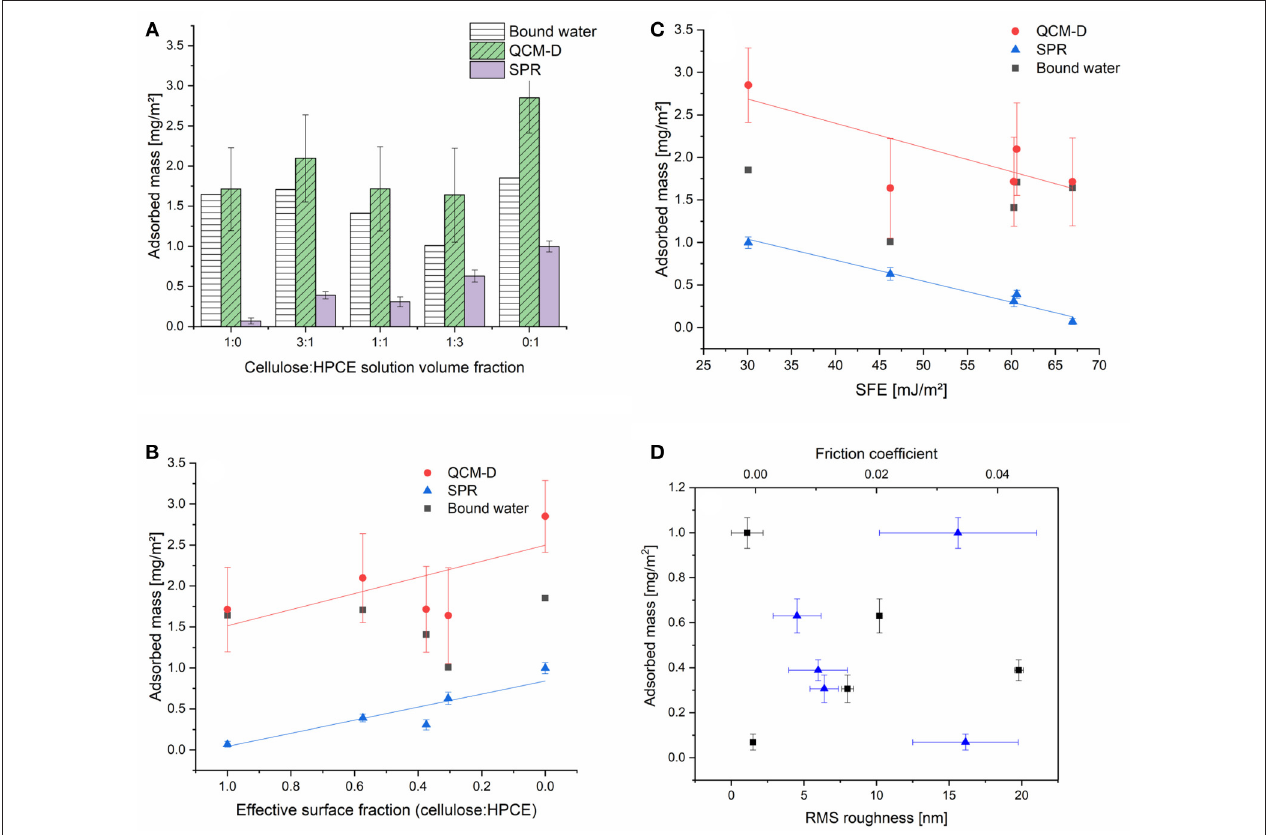
FIGURE 6 | (A) Adsorbed mass (mg m − 2 ) of BSA on the cellulose:HPCE blend films determined by SPR and QCM-D. Adsorbed masses with respect to the (B) surface fraction, and (C) surface free energy. (D) RMS roughness (squares) from the AFM measurements and friction coefficients (triangles) from the FFM analysis contrasted to the adsorbed amount based on SPR